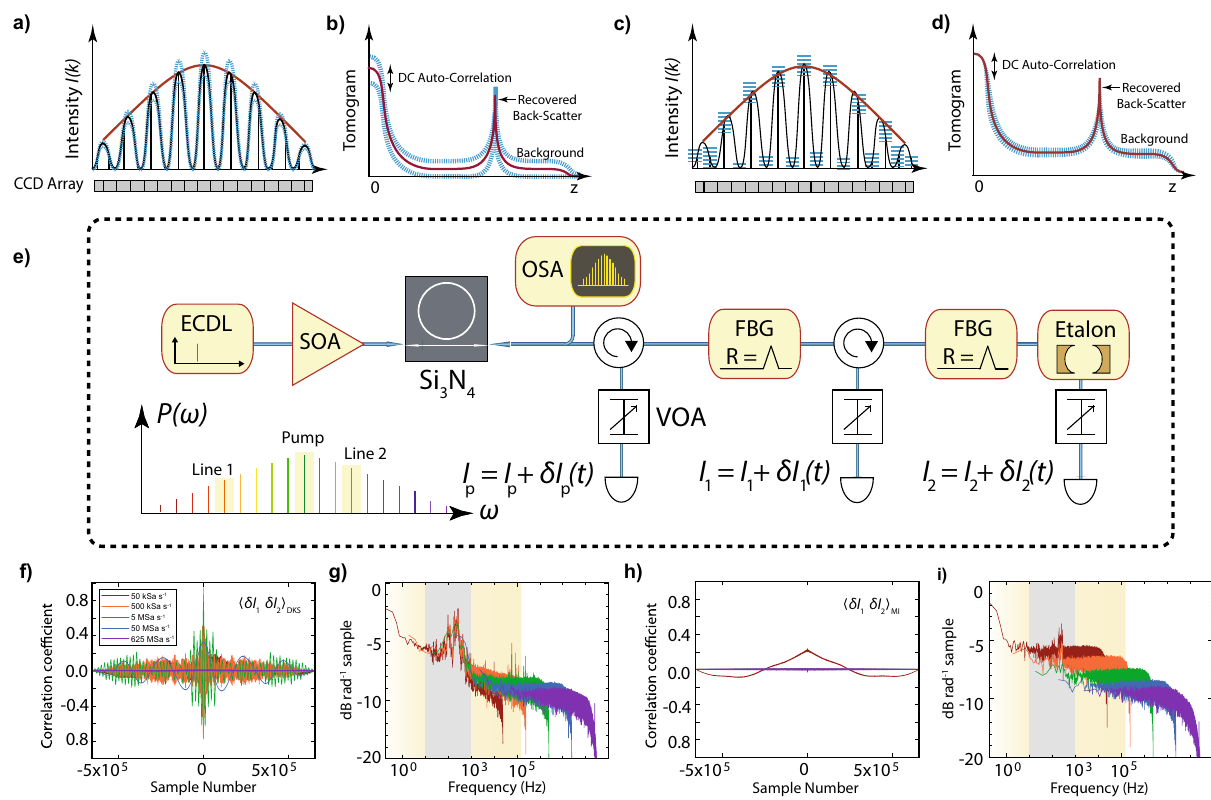
Fig. 3 Frequency dependent noise correlations. a A frequency comb interferogram (black) is dispersively projected onto a charged-coupled device (CCD) array and its correlated intensity noise (blue) modulates the full comb envelope (red). b Upon Fourier transformation, the tomogram ’ s DC peak is sensitive to the noise, but no change in background signal-to-noise ratio and dynamic range occurs. c In the case of uncorrelated intensity noise between various comb lines, each line of the interferogram exhibits uncorrelated noise, which manifests in the tomogram seen in d as an increase in background signal. e Setup for intensity noise correlation measurement: the source, comprising an external cavity diode laser (ECDL), a semiconductor optical ampli fi er (SOA), the microchip and an optical spectrum analyser (OSA) generates dissipative Kerr soliton (DKS) and modulation instability (MI) states by laser piezo tuning. Various lines are then fi ltered from the resulting spectrum using fi ber Bragg gratings (FBG), sent through variable optical attenuators (VOA), and sampled with a high-resolution oscilloscope. f , h The cross correlation of lines "1" and "2" for the DKS and MI states, where lines "1" and "2" correspond to 1272 nm and 1320 nm, respectively. The x -axis denotes the relative lag in units of the inverse sampling rate, as derived from the samples per second (Sa s − 1 ), with all color indications shared between sub- fi gures. g , i Depict the cross power spectral densities corresponding to f and h , respectively. In the spectral plots, the gray shaded region highlight technical noise, likely originating from acoustic modes of the input- and output coupling fi bers, while the yellow shaded region indicates the range of typical SD-OCT A-scan